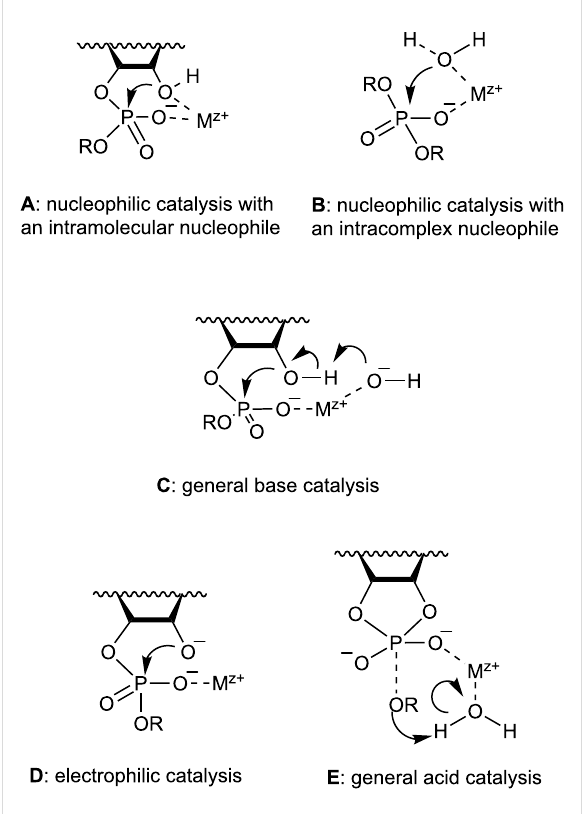
stant for the chemical cleavage of HPNP under the same condi- tions is 0.7 s − 1 , the latter binding step is rate-limiting. With the less reactive DNA analog, MePNP, the chemical cleavage step still is clearly